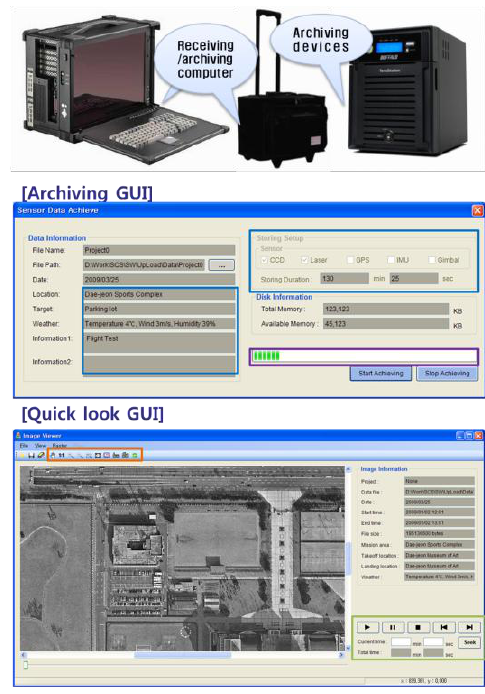
Figure 8. Receiving & archiving subsystem